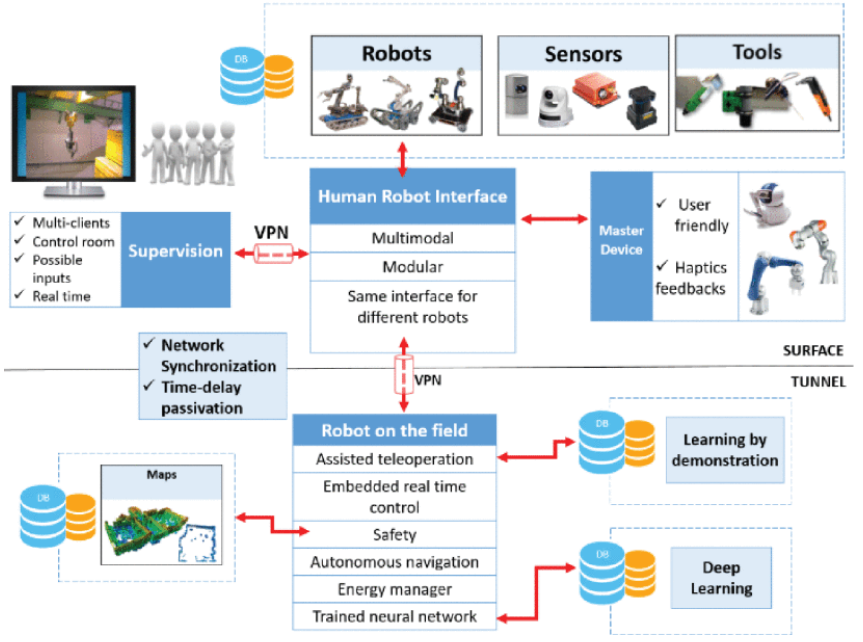
Figure 3. CERNTAURO